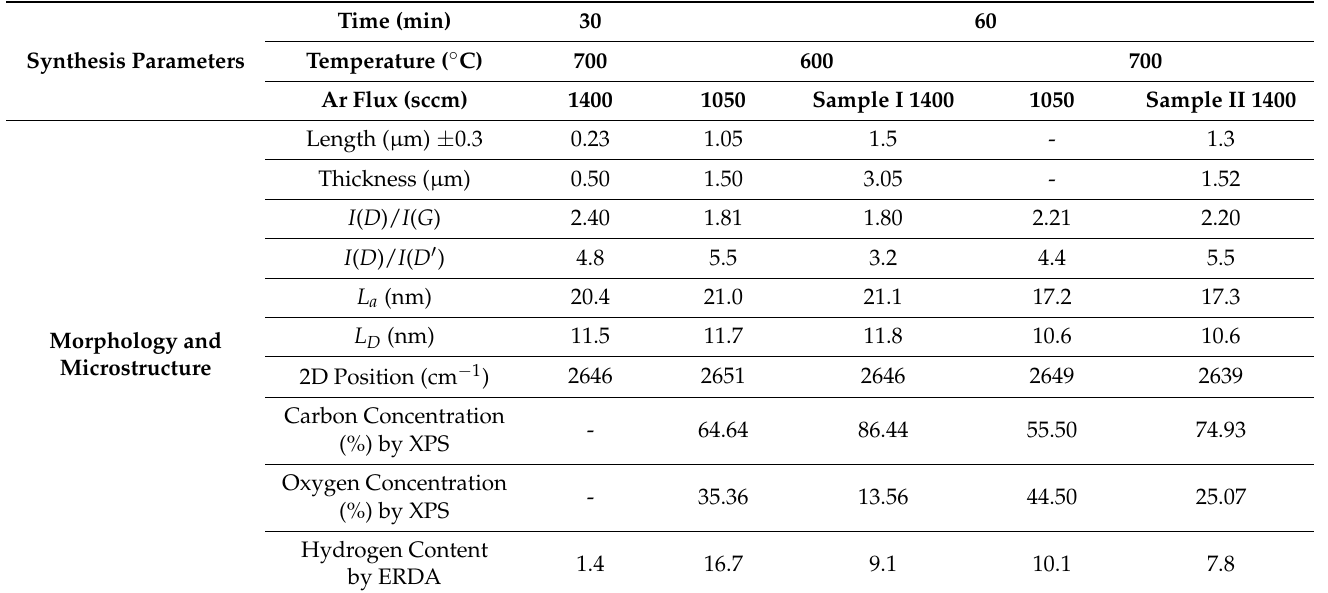
Table 1. Values obtained from SEM, TEM, ERDA and Raman spectra of the CNWs formed at different synthesis parameters: time, deposition temperature and Ar